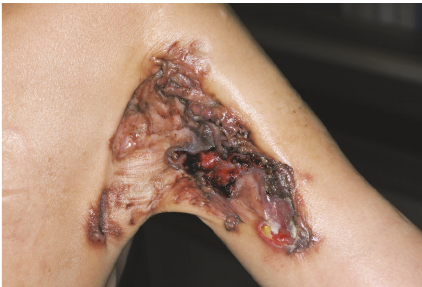
Figure 1: The large nodulo-ulcerative plaque with bleeding seen on frontal view; located at the back of the right upper arm, measuring 12 cm × 6 cm.